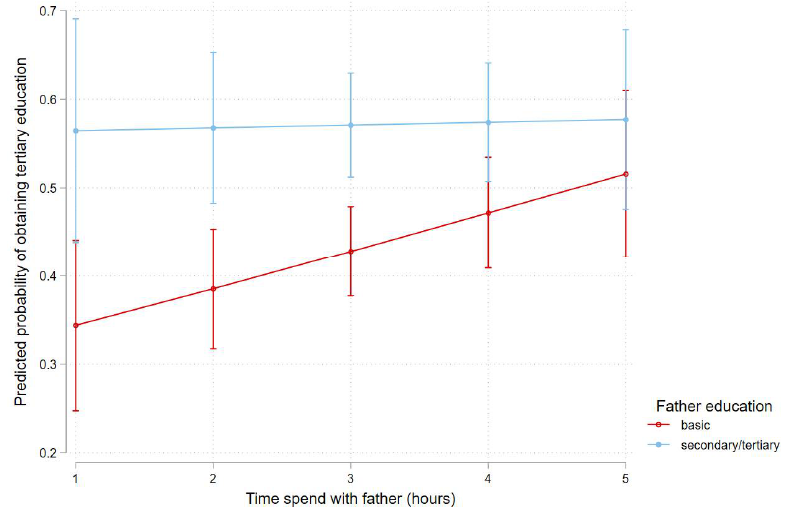
Figure 1. Interaction of fathers’ education with time spent with fathers in 1979 on teenager’s likelihood of completing tertiary education by the age of 40.